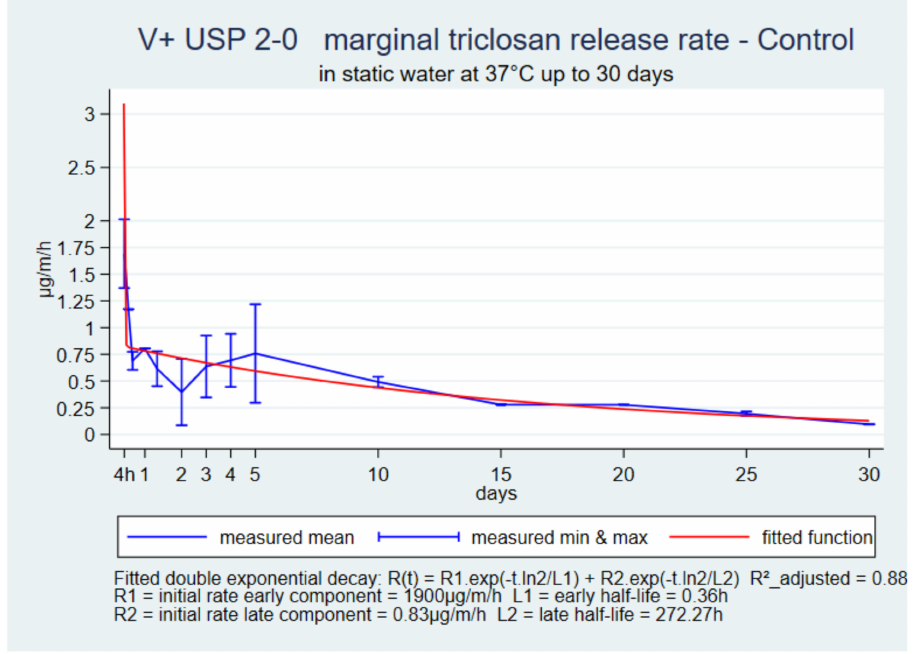
Figure 1. V+ USP 2-0, marginal release rate in static up to 30